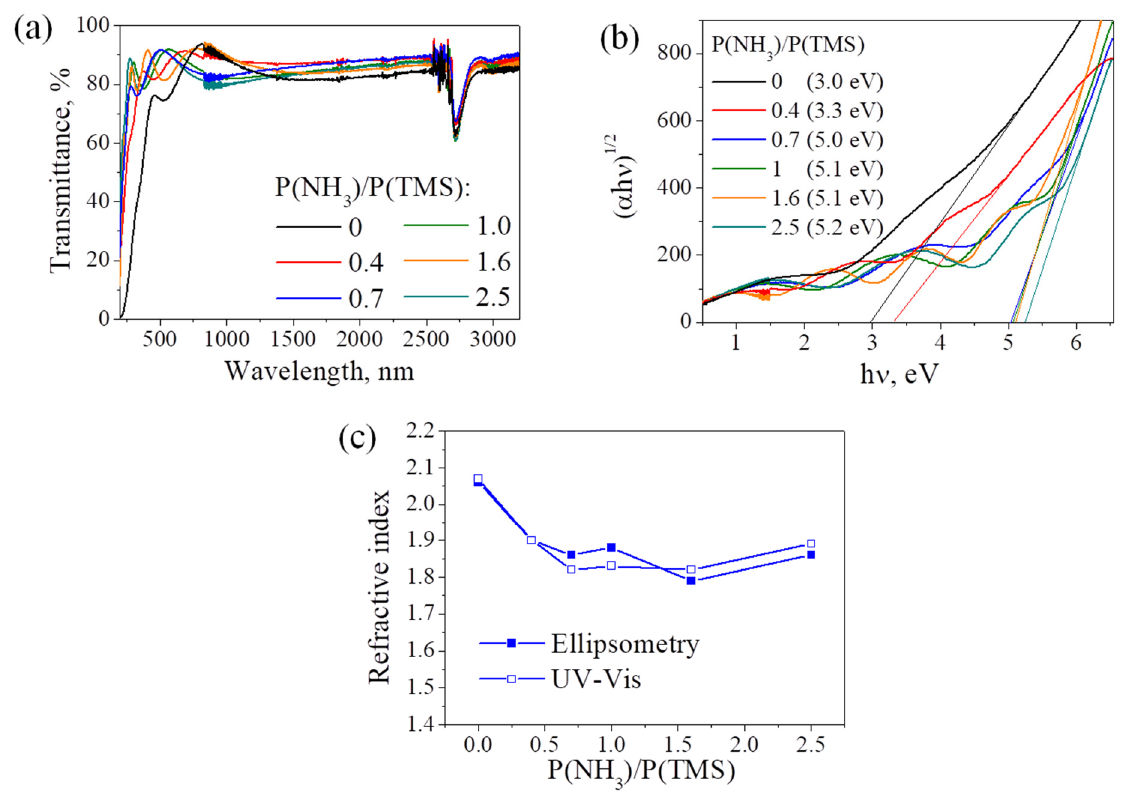
Figure 7. Optical properties of SiC:H (SiCN:H) films: evolution of transmittance of SiCN:H/SiO 2 structures ( a ), optical bandgap ( b ), and refractive index ( c ), with variation of gas ratio in the initial mixture of NH 3 /TMS.